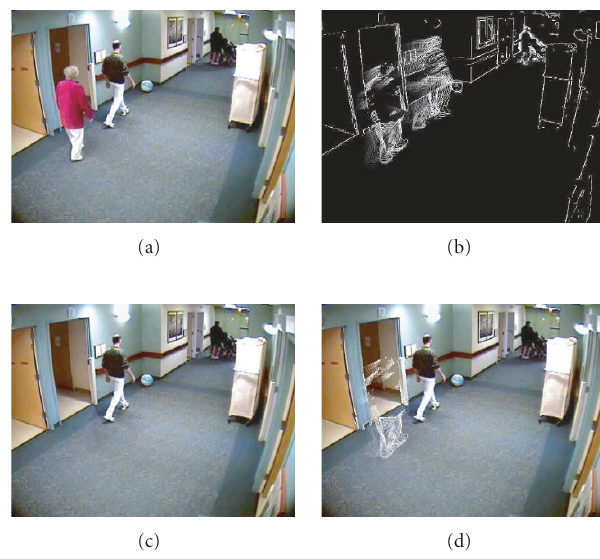
Figure 5: Accuracy with di ff erent sizes of training sets. Figure 6: An example of people obscured by using the EMHI. (a) The original image, (b) its EMHI result, (c) the background restora- tion of the woman in pink identified from the original video frame. The background is learned in the background subtraction intro- duced in Section 3. (d) The final obscured